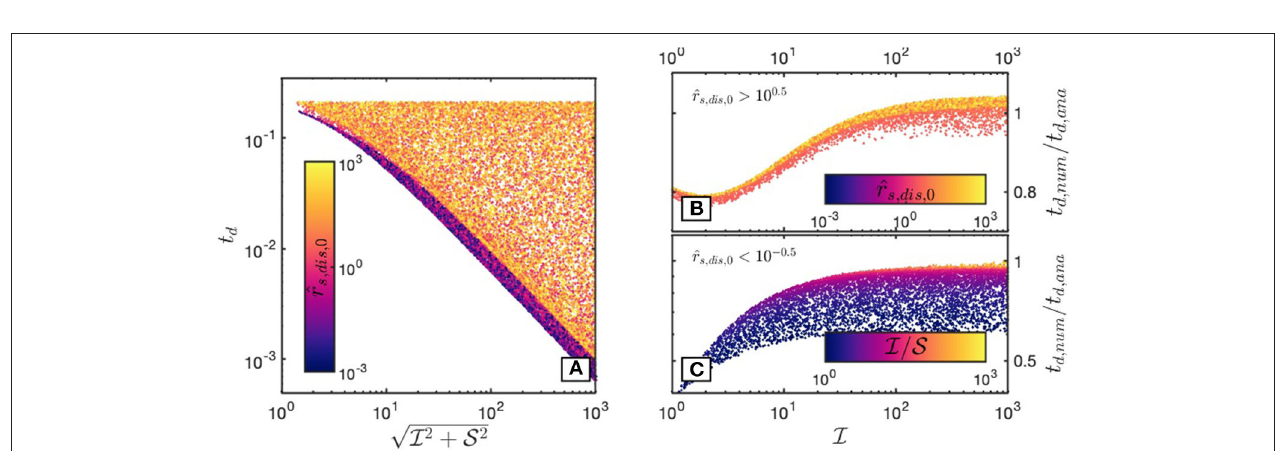
FIGURE 8 | Detachment times t d for a simulation subset with I > 1 and S > 1 (large interface and thermal damage). (A) t d as a function of the combination of the grain damage parameter I and the thermal damage parameter S . Colors denote the value of is more dominant during necking). (B) Validity of the analytical detachment time prediction for a subset of the simulations shown in (A) with creep controlled necking). Shown is the ratio t d , num / t d , ana between the respective numerically computed detachment time and the analytical prediction (given by Equation 50). (C) Same as (B) , but for a subset of the simulations shown in (A) with appropriate to predict the detachment time. Colors denote the ratio between the grain damage parameter and the thermal damage parameter.